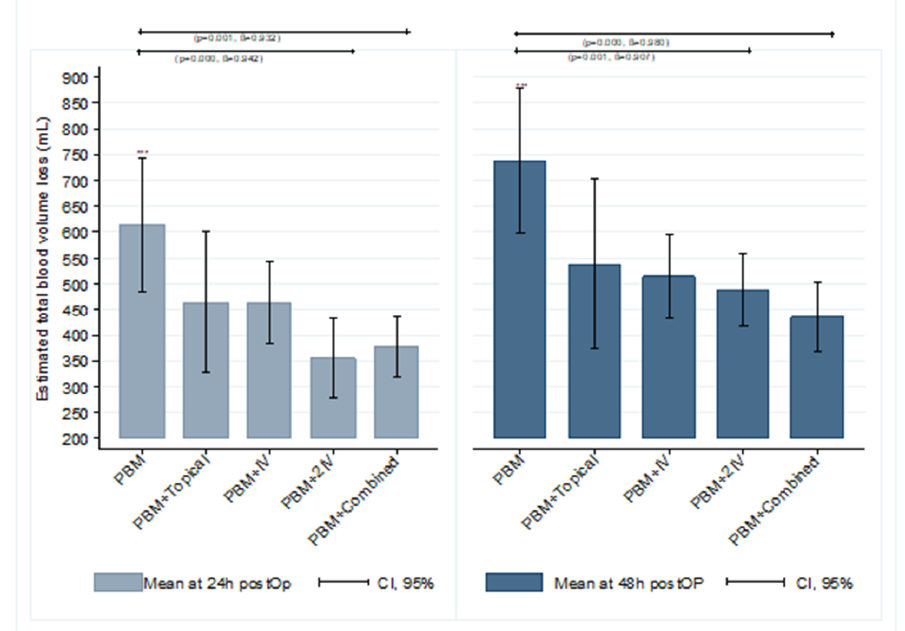
Figure 2. Total blood volume loss at 24 and 48 h postoperative by group of treatment. *** The mean estimated blood loss volume shows differences (Kruskal–Wallis test) between the PBM group and PBM + 2IV and PBM + Combined groups at 24 and 48 h. No differences were found in comparisons between each TXA group with other TXA groups ( p > 0.05, ß < 50%). J. Clin. Med. 2020 , 9 , x FOR PEER REVIEW After controlling the TBV loss at 48 h postop with the associated covariates in the GLM model (Table 3), no differences were found among all the groups that received the PBM program and at least one dose of TXA against the PBM group (Figure 3). Compared to PBM, the difference of predicted TBV varied from −238 mL, if treated in the PBM + Topical group, to −295 mL, if treated in the PMB + Combined group.